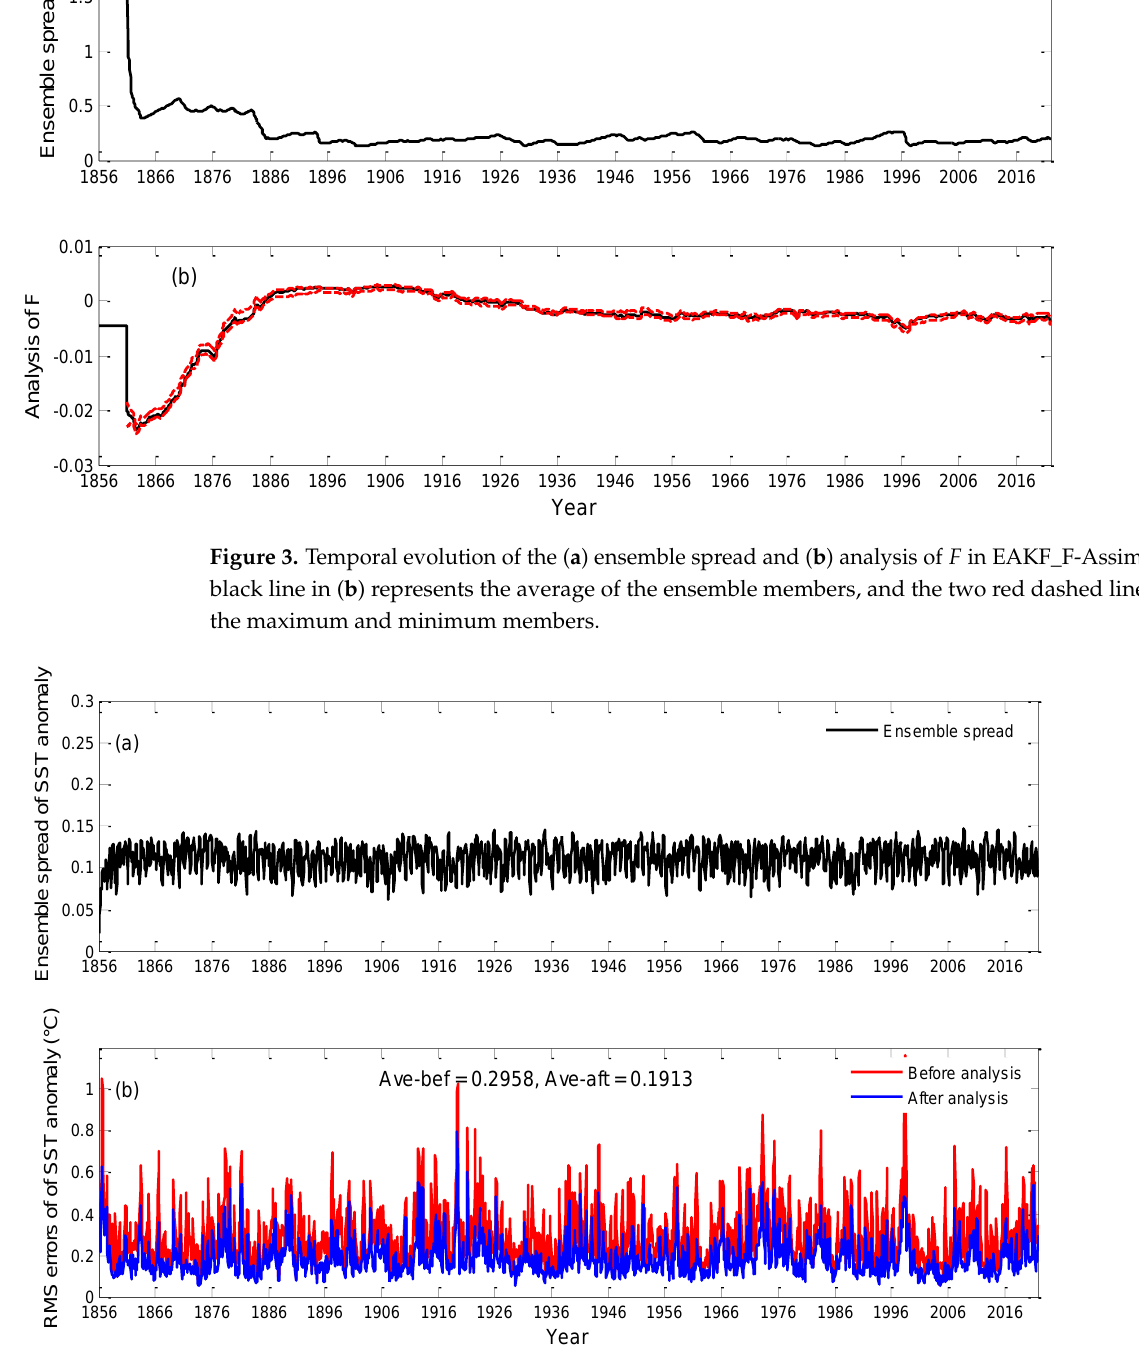
Figure 5. Time series of ZWS anomalies in the Niño3.4 region: ERA-20C reanalysis and simulations from Ori-Assim, EAKF-Assim, and EAKF_F-Assim schemes in black, green, red, and blue lines, respectively.